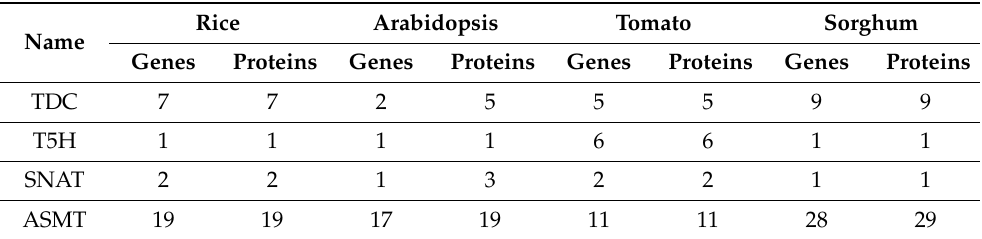
Table 1. Details of the genes and proteins involved in Ser and Mel biosynthesis in various model monocot and dicot plant